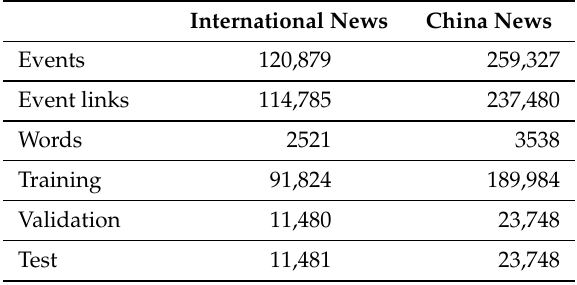
Table 1. Statistics of datasets.